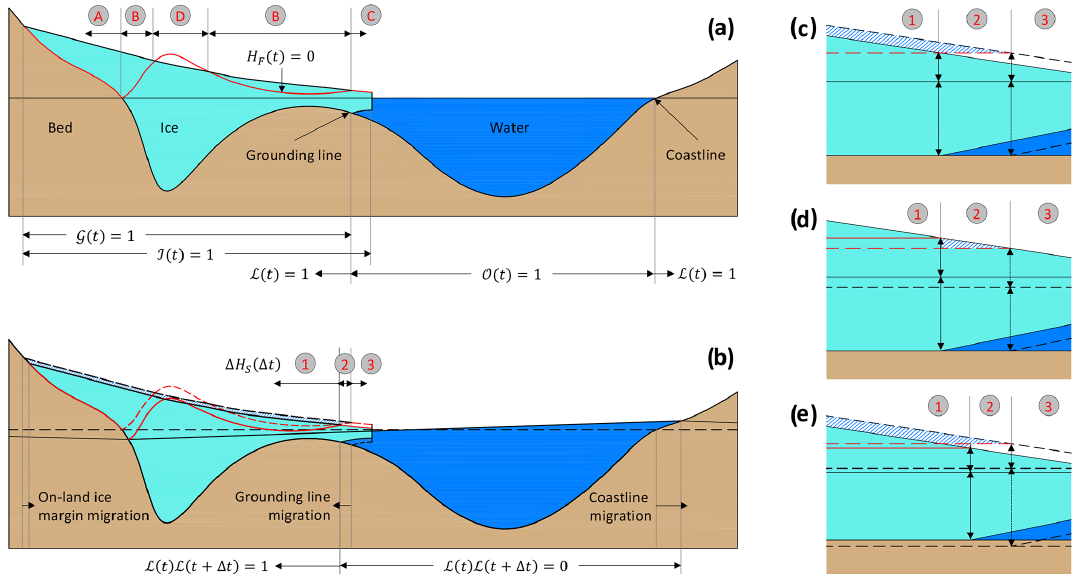
Figure 2. Conceptual depiction of an evolving ice-sheet geometry. (a) Domains of ocean O , land L , ice I and its grounded portion G at time t . The floatation height, having H F = 0, is represented by the red line. Ice height above floatation satisfies the condition H F = H in Sector A, 0 < H F < H in Sector B, H F = 0 in Sector C and H F < 0 in Sector D. (b) Ice-sheet geometry at time t + (cid:49)t after changes in ice thickness and MSL. (For simplicity, bedrock change is not considered.) Old geometry and field variables are shown with dashed lines. Ice thickness that contributes to sea-level change, (cid:49)H S , is given by (cid:49)H in Regime 1 and by (cid:49)H F + ( 1 − ρ w /ρ o )((cid:49)H − (cid:49)H F ) in Regime 2 and Regime 3. The hatched area contributes to the ocean mass change (Eq. 11). Since (cid:49)H F = 0 in Regime 3, it contributes to sea level by modulating the ocean volume (not mass) alone (Eq. 12). We zoom in around the grounding line to assess different scenarios: (c) when ice thickness changes but the bedrock and MSL do not, typically assumed in stand-alone ice-sheet models; (d) when externally forced MSL changes but ice thickness does not; and (e) when ice thickness, bedrock and MSL all evolve simultaneously. Sketches are not to scale. (cid:104)(cid:110) S(ω,t) + (cid:49)S(ω,(cid:49)t) where H 0 (ω,t + (cid:49)t) = ρ o /ρ i max